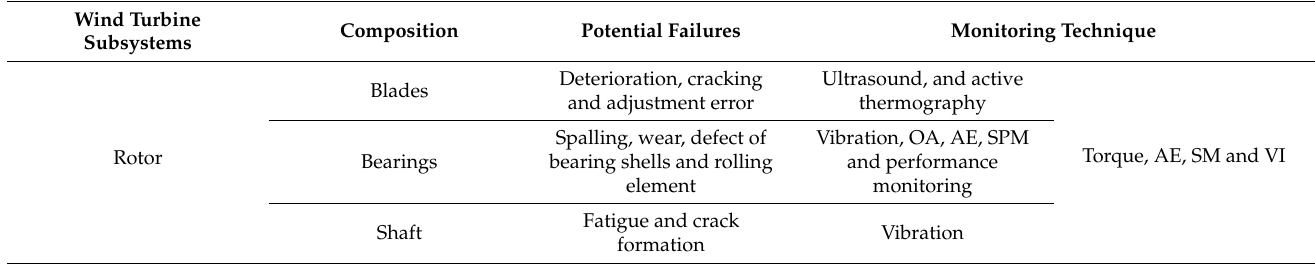
Figure 17. Forms of wind turbine maintenance [166]. Table 2. For modules and subsystems of wind turbines, a summary of potential malfunction mechanisms and associated monitoring techniques [145] is given. (AE: Acoustic emission, OA: Oil analysis, SM: Strain measurement, SPM: Shock pulse